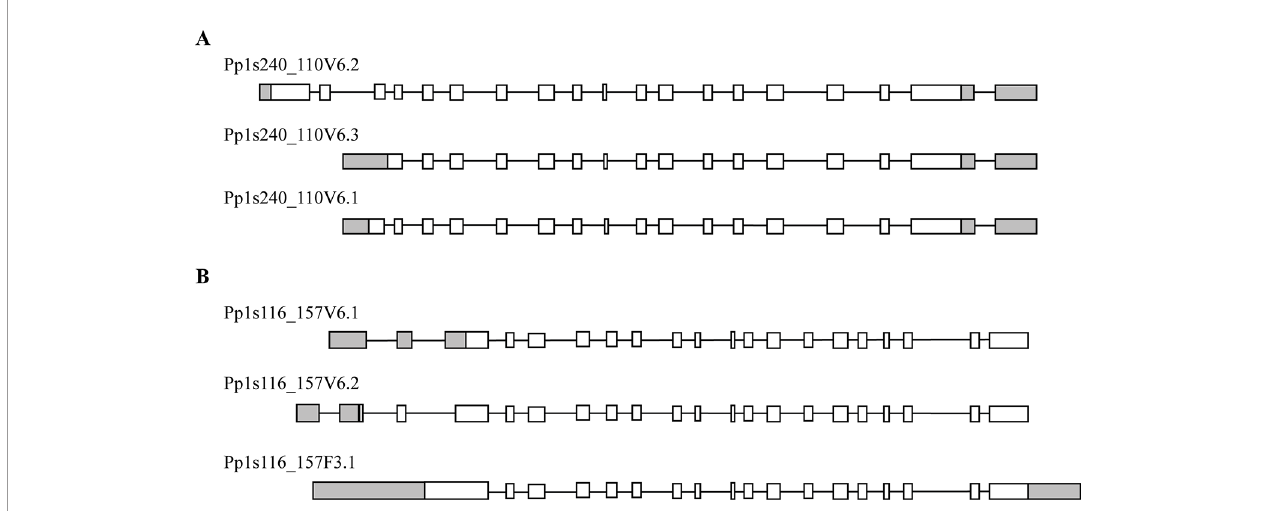
FIGURE 2 | Predicted models by Cosmoss database of the PpTPS1 (A) and PpTPS2 (B) genes. Pp1s240_110V6.1, Pp1s240_110V6.2, Pp1s240_110V6.3 and Pp1s116_157V6.1, Pp1s116_157V6.2, Pp1s116_157F3.1 are different splice variants of PpTPS1 and PpTPS2 , respectively. White boxes represent exons, black lines indicate introns, and gray boxes show UTR (untranslated